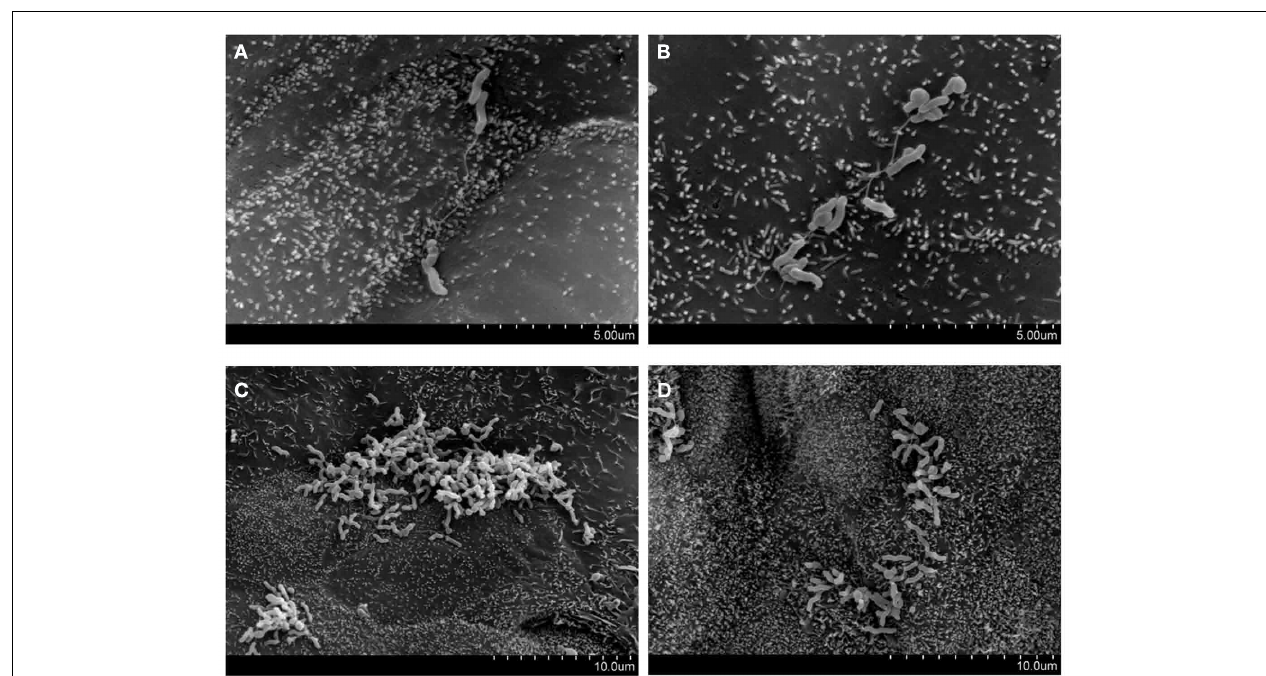
FIGURE 2 | Preferential attachment of Campylobacter concisus UNSWCD to intercellular junctional spaces of host cells (adapted from Man et al., 2010a). HT-29 cells were infected with bacteria at a MOI of 200 for 6h. (A–D) C. concisus UNSWCD preferentially attached to areas resembling the intercellular junctional